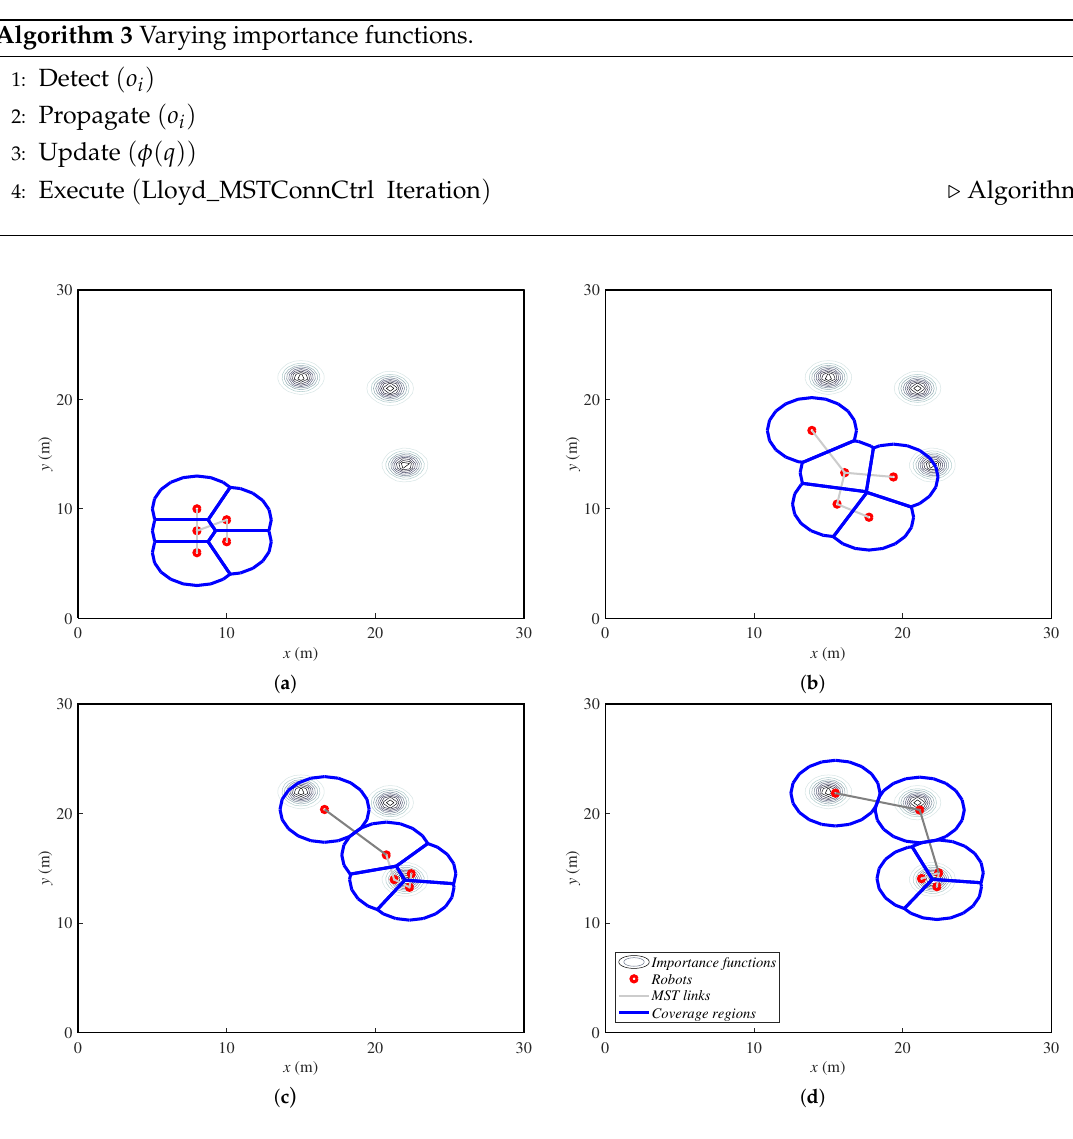
Figure 3. Ground robots’ positions in four steps (( a ) step 1, ( b ) step 6, ( c ) step 15 and ( d ) step 30 of 30) while covering three fixed targets, which are assigned importance functions. MST, Minimum Spanning